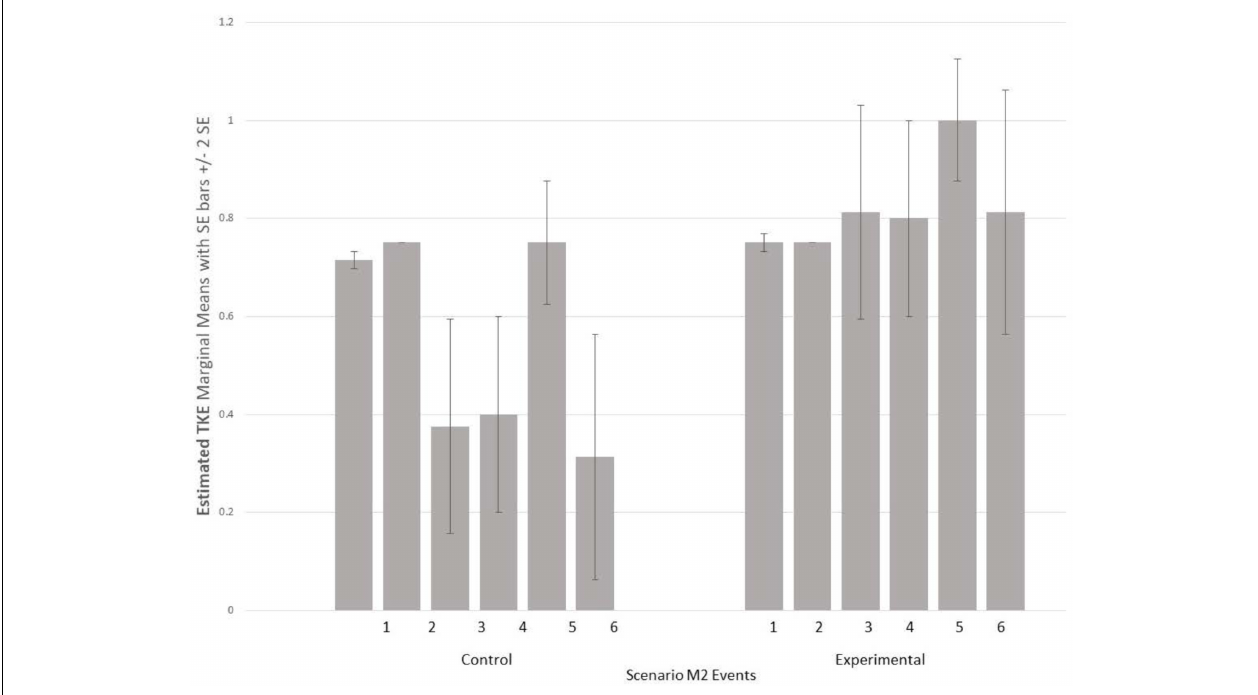
FIGURE 1 | Estimated TKE marginal means and standard error for M2 scenario